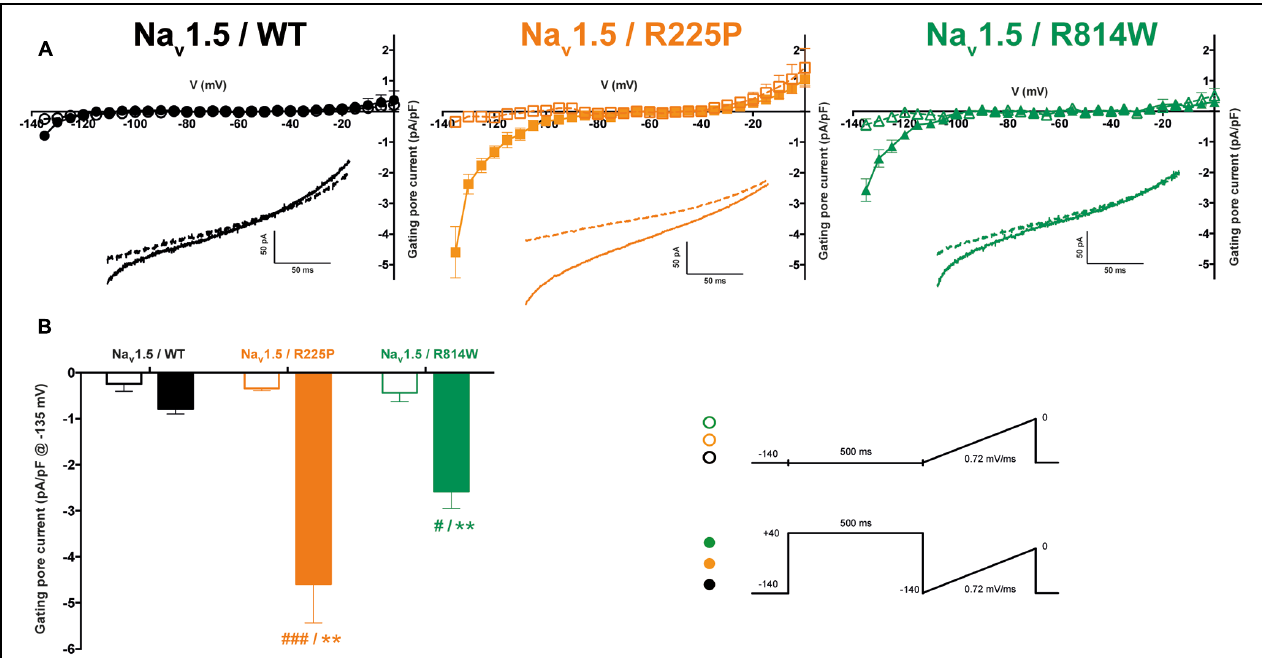
FIGURE 5 | Gating pore currents after long depolarizations. (A) Currents generated by ramp pulses (see protocols in inset) for the WT (left), R225P (middle), and R814W (right) channels. The I–V curves were constructed by averaging current values every 5 mV. Voltages were calculated using the known time course of the ramp protocol. A linear leak subtraction around − 75 to − 45 mV was performed to eliminate the inherent linear leak. The insets show the currents in response to the ramp protocols. Dashed lines indicate the current obtained without pre-depolarization while solid lines indicate the response after a 500-ms pre-depolarization at + 40 mV. (B) Histogram summarizing the inward gating pore current density at − 135 mV recorded with or without a 500-ms pre-depolarization. ∗ Indicates a statistical difference between the condition with or without pre-depolarization tested using a t -test ( ∗∗ P < 0.01); # Indicates differences with the WT channel (with the 500-ms pre-depolarization) tested using an ANOVA. (# P < 0.05, ### P < 0.001)